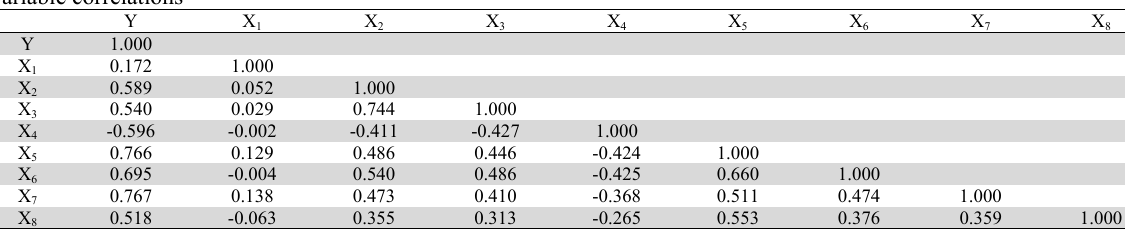
Results of tests on multicollinearity, heteroscedasticity and autocorrelation Multicollinearity test